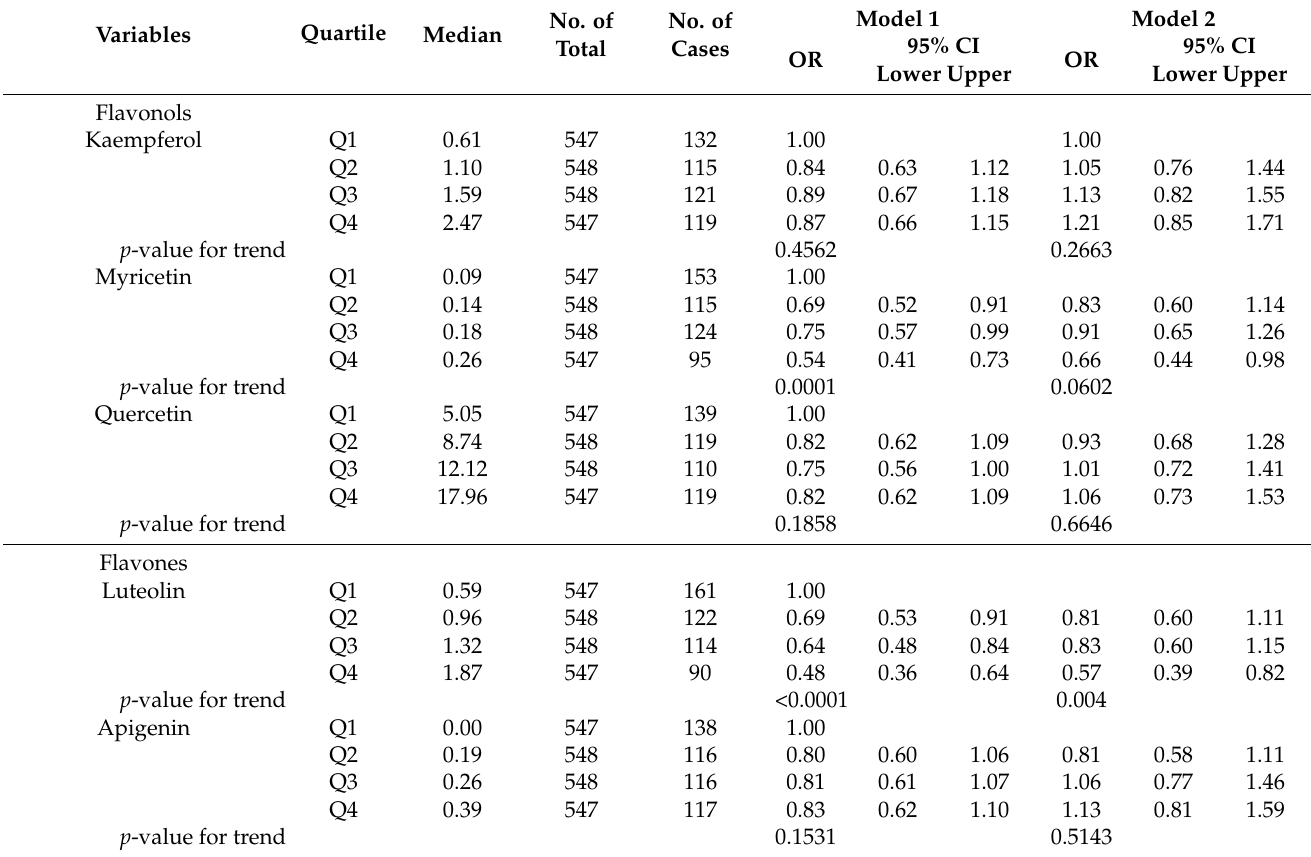
Table 4. Association between individual phenolic compound intake and prevalence of depressive symptoms in multivariate-adjusted logistic regression